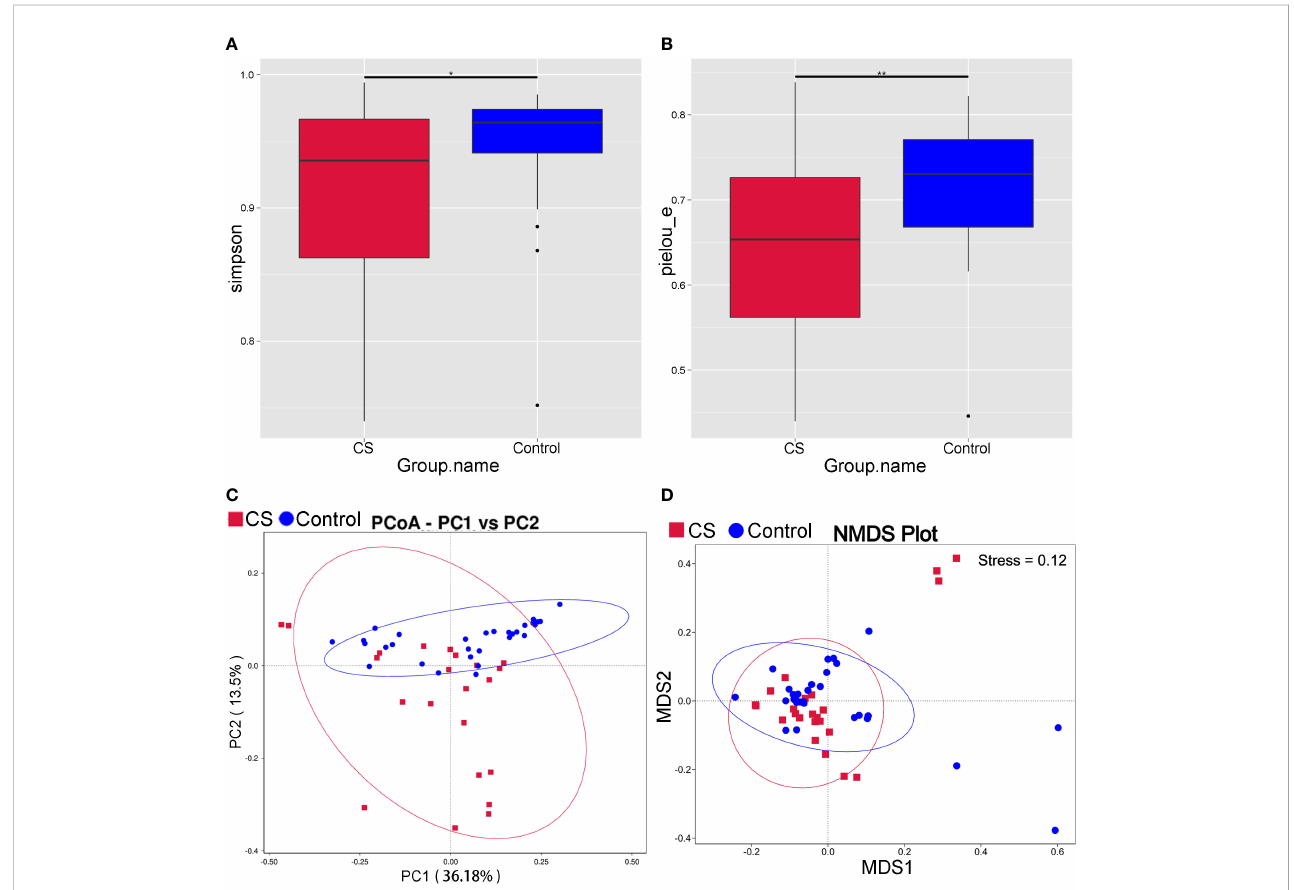
FIGURE 1 Analysis of intestinal microbiota diversity in Cushing ’ s syndrome patients and controls. (A) : Simpson index decreased in the Cushing ’ s syndrome group ( P < 0.05); (B) : Pielou_e index decreased in the Cushing ’ s syndrome group ( P < 0.01); (C) : PCoA analysis displayed that the Cushing ’ s syndrome group had a bacterial community composition distinct from that of the control group; (D) : NMDS analysis depicted that gut microbiota community structure of the Cushing ’ s syndrome group was different to the control group. CS, Cushing ’ s syndrome. * P <0.05; ** P <0.01. PCoA,Principal coordinate analysis; NMDS, non-metric multidimensional